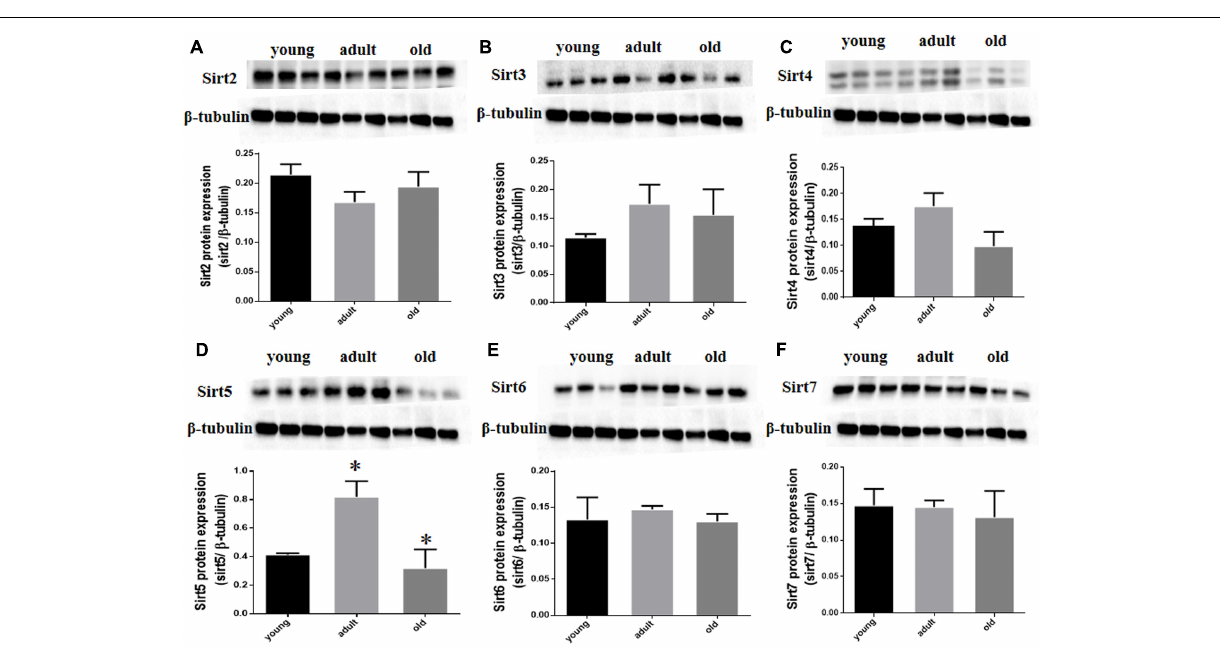
FIGURE 6 | SIRT2-7 protein levels in aging rat retinal neurons. Representative western blots showing the protein levels for SIRT2 (A) , SIRT3 (B) , SIRT4 (C) , SIRT5 (D) , SIRT6 (E) and SIRT7 (F) in the retinas of young, adult, and old rats. The histograms in each panel show the densitometric mean and SEM normalized to the corresponding level of the loading control protein β -Tubulin ( ∗ P < 0.05, n = 4 independent